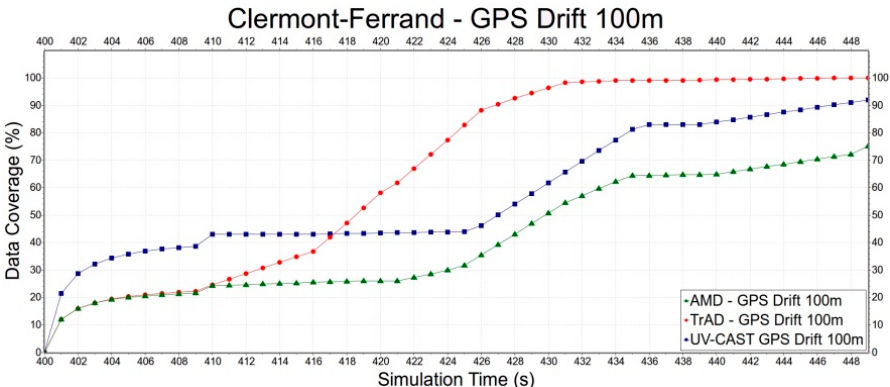
Figure 17. The data dissemination speed of TrAD, AMD and UV-CAST with 100 m GPS drift.